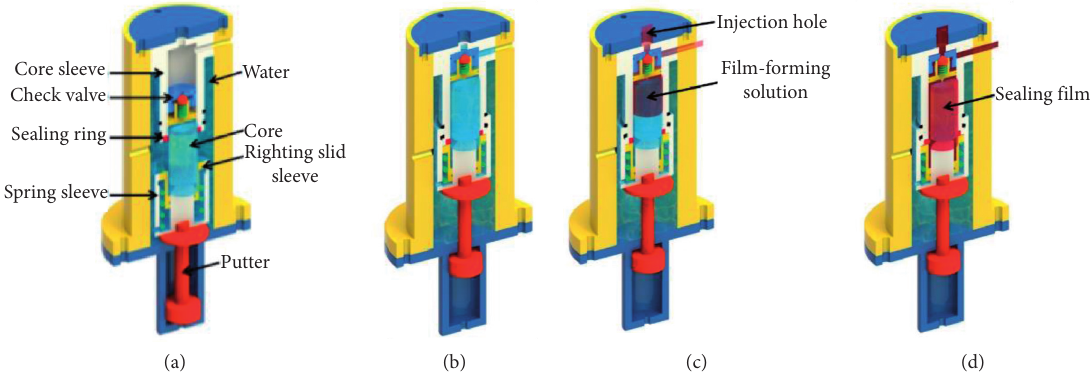
Figure 12: Schematic of the quality-preserving coring simulator operation: (a) before coring; (b) after coring; (c) core covered with film- forming solution; (d) crosslinking